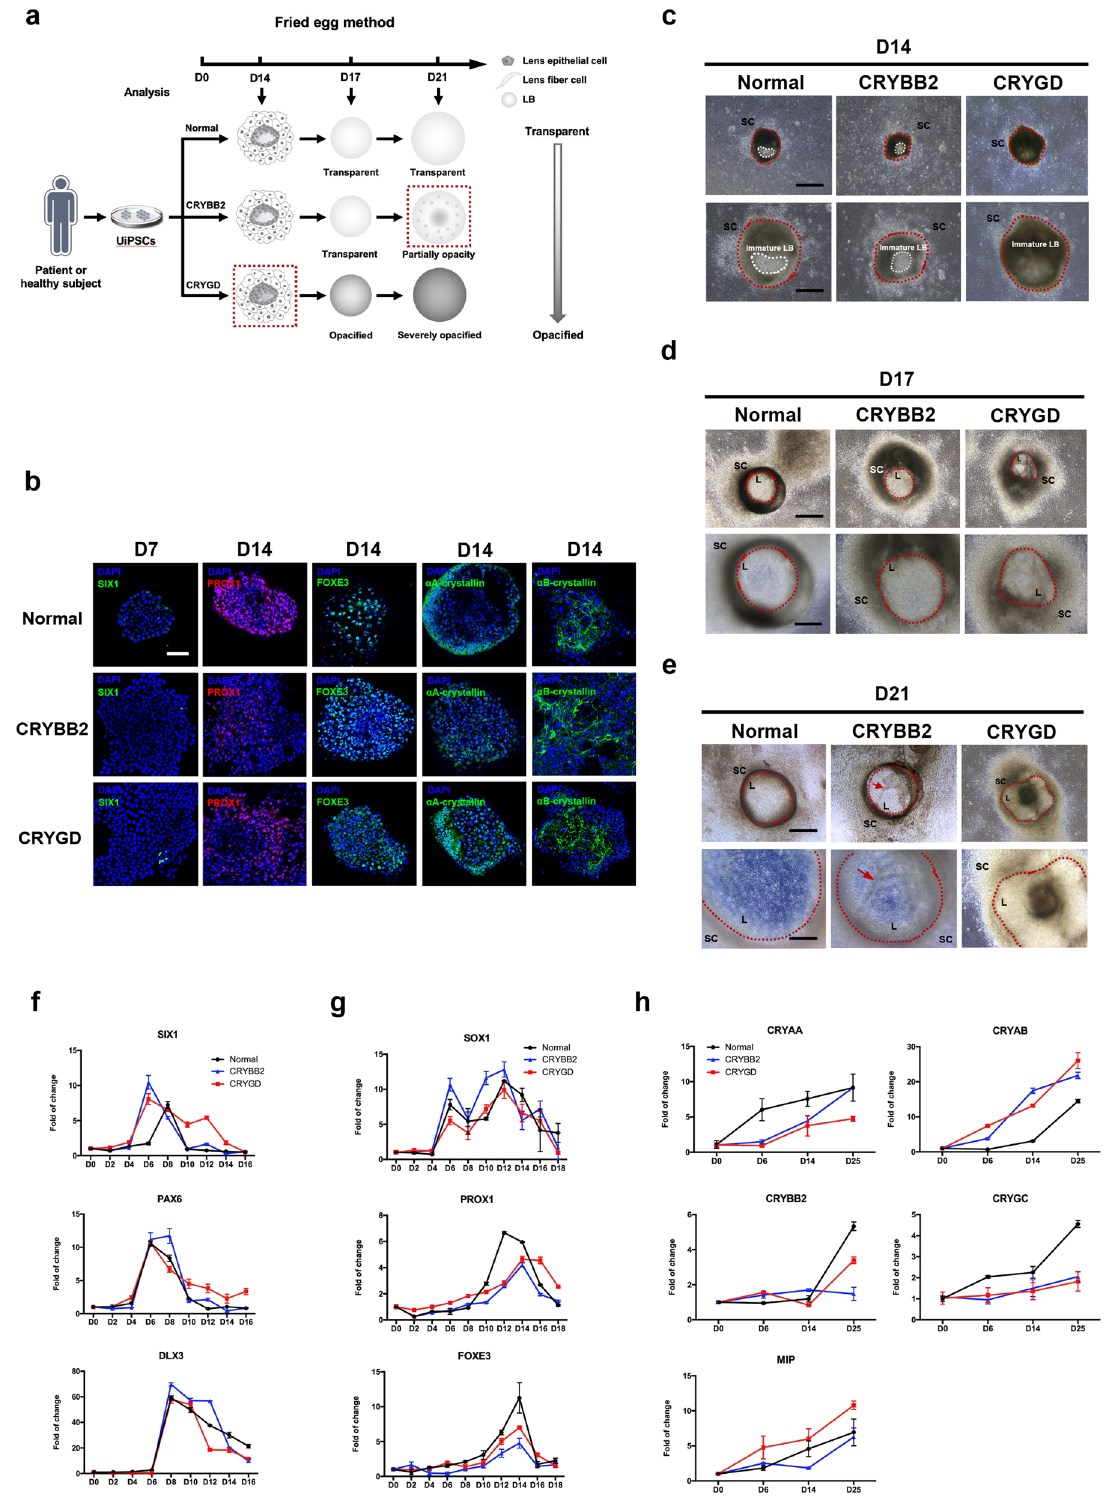
Fig. 5 Comparative analysis of the differentiation process of the normal, CRYGD -, and CRYBB2 -mutated LBs. a Schematic of alteration in the morphology of the normal, CRYGD -, and CRYBB2 -mutated LBs during the mid-to-late stage of differentiation. b Immuno fl uorescence analysis of the placodal marker SIX1 (D7) as well as the early lens-speci fi c markers PROX1, FOXE3, α A-, and α B-crystallin (D14) in the normal and patient-speci fi c LBs. Scale bars: 100 μ m. c – e Representative images of the normal and patient-speci fi c LBs on D14 ( c ), D17 ( d ), and D21 ( e ), respectively. The red dashed lines indicate the borders of the LBs. The white dashed lines indicate the transparent region in the immature LBs on D14. The red arrows indicate a cord-like structure in the CRYBB2 -mutated LBs on D21. L: LB; SC: supporting cells. Scale bars: 250 μ m (upper panels), 100 μ m (lower panels). f – h qRT-PCR analysis of the placodal markers ( f ), human early lens-speci fi c markers ( g ), and human mature lens-speci fi c markers ( h ) in the normal and patient-speci fi c LBs during differentiation. The data are presented as the mean ± SD of experiments from at least three parallel samples per